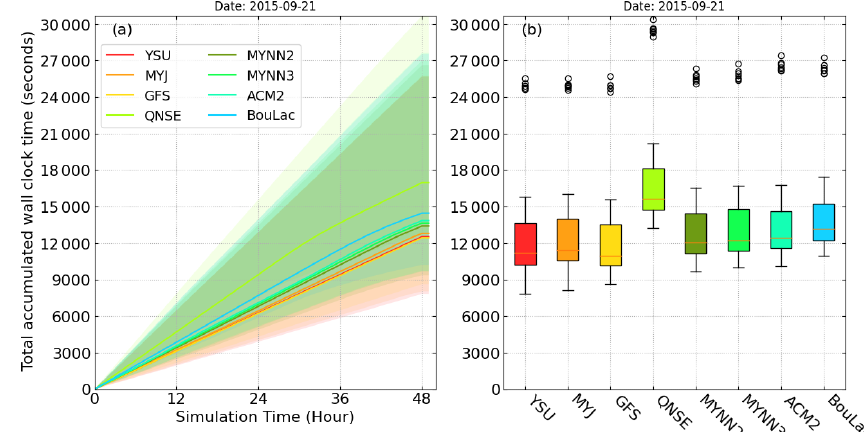
Figure 5. The (a) total accumulated simulation time. (b) A box plot of different PBL configurations within each simulation hour on 21 September 2015. The upper and lower boundaries of the color fill indicate the maximum and minimum simulation time with other physics configurations.